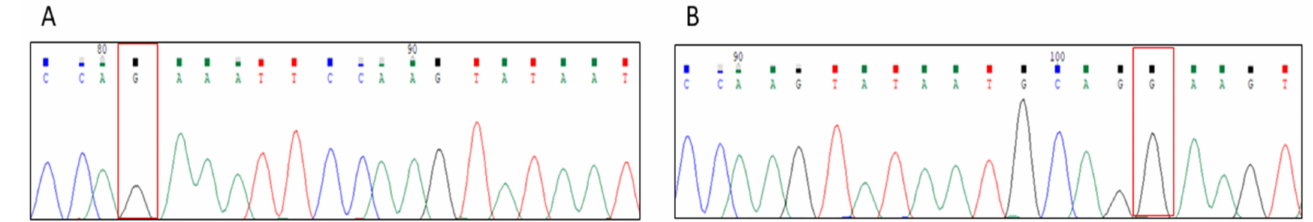
Figure 2. Example of the sequencing results of the molecular cloning performed to determine the cis-trans nature of the variants in the PSEN1 gene. Twelve clones with p.Lys311Arg (K311R) ( A ) and seven clones with p.Glu318Gly (E318G) ( B ) were